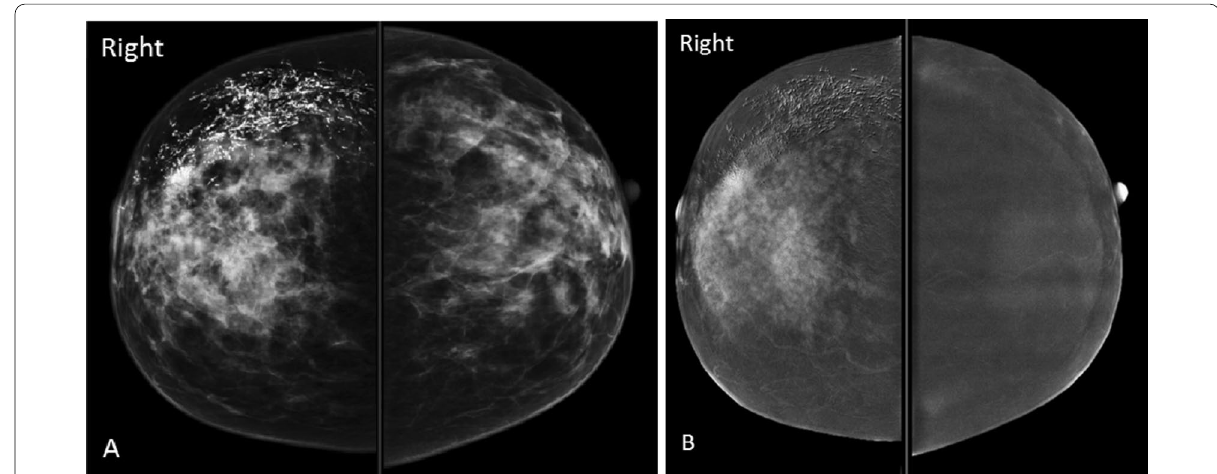
Fig. 2 A 35-year-old female that had a palpable left breast lump. a Bilateral digital mammogram craino-caudal views that showed right breast upper outer and central regional asymmetrical density and associate upper outer segmental clustered pleomorphic microcalcifications malignant looking masses that extent beyond the confine of the asymmetrical density. b CEM of both breasts craino-caudal view that showed heterogeneous enhancement of the right breast asymmetrical density, while the area involved with the clustered microcalcifications showed no contrast uptake. The case was proved to be invasive ductal carcinoma and ductal carcinoma in situ. CEM images provided information about the actual extent of the disease in the form of a vascular enhancing invasive component and the distribution of the non-enhancing component of calcifications. This can significantly change the management from breast-conservative surgery to